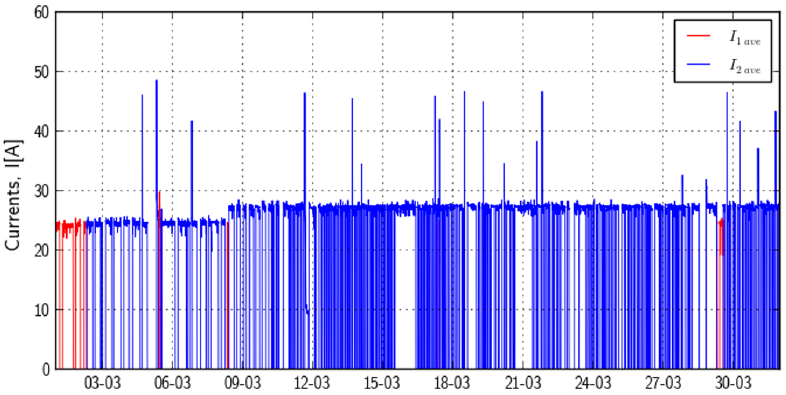
Figure 28. An example of the PU2 replacement performed on 8 March 2010, visible through the load current change diagram.